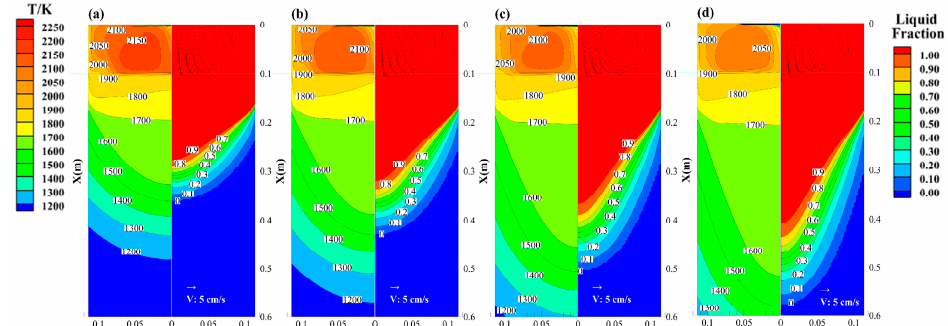
Figure 1. Temperature distribution (left of each figure) and liquid metal volume fraction distribution (right of each figure) at varying melting rates at end of steady state: ( a ) 90 kg/h, ( b ) 120 kg/h, ( c ) 150 kg/h, and ( d ) 180 kg/h.